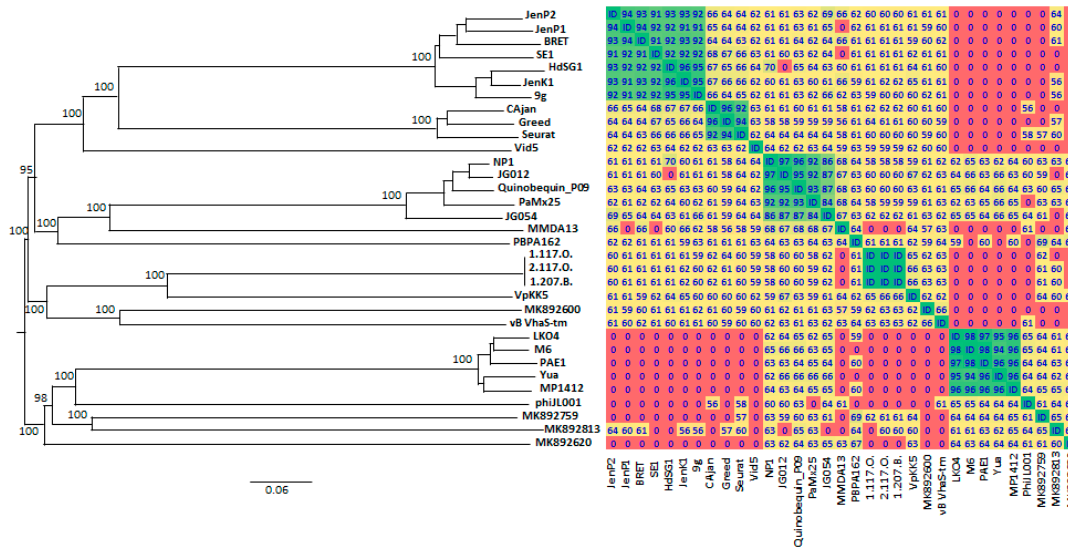
Figure 7. Phylogenomic Genome-BLAST Distance Phylogeny (GBDP) (on the left) and Orthologous Average Nucleotide Identity (OrthoANI) (on the right) analyses between vB_StuS_MMDA13 and the nearest members of Siphoviridae family. Only bootstrap values ≥ 95%, obtained by 100 replications in the GBDP analysis, are showed. Overall genomic sequence identity values are shown with different colours in a heatmap generated with the OrthoANI results. Cut-off is set at 50%: lower values are indicated as “0”. The following abbreviations are used: HdSG1, vB_EcoS_HdSG1; Vid5,